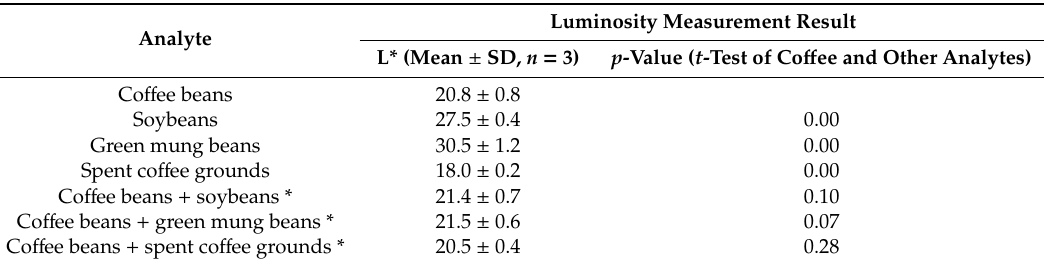
Table 1. L* values of coffee beans , adulterants and adulterated coffee beans .